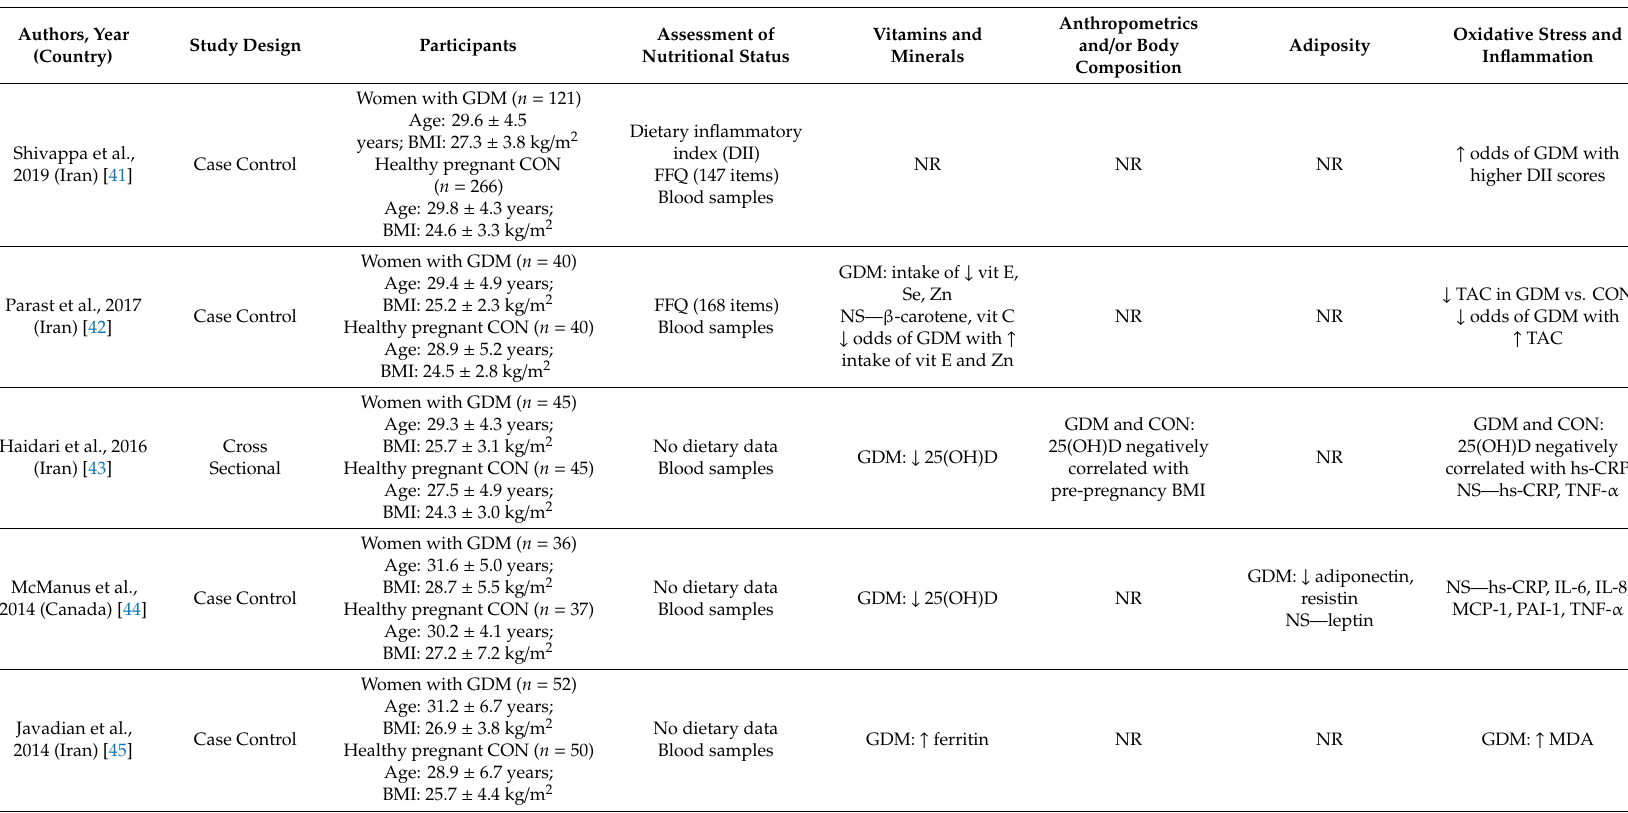
Table 1. Observational studies on maternal biomarkers of adiposity, antioxidant vitamin and mineral status, oxidative stress, and inflammation in gestational diabetes